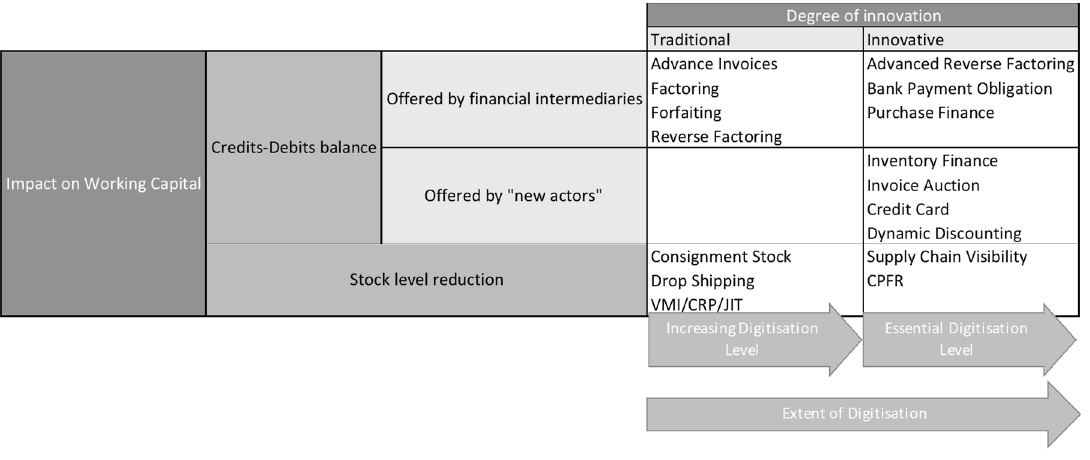
Figure 2. Classification of the main supply finance solutions (Observatory for Supply Chain Finance 2016).